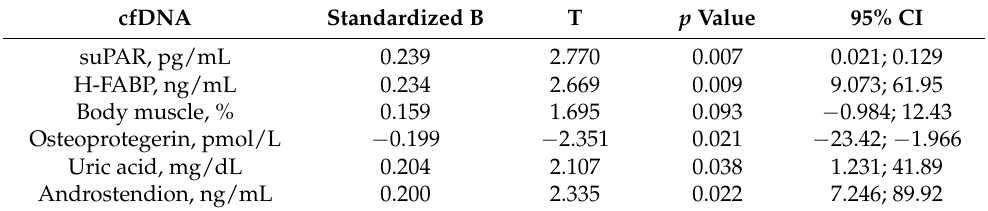
Table 2. The multiple correlation coefficient was 0.620 representing a good level of predic- tion. Table 2. Backwards multiple linear regression analysis of cfDNA levels at baseline.